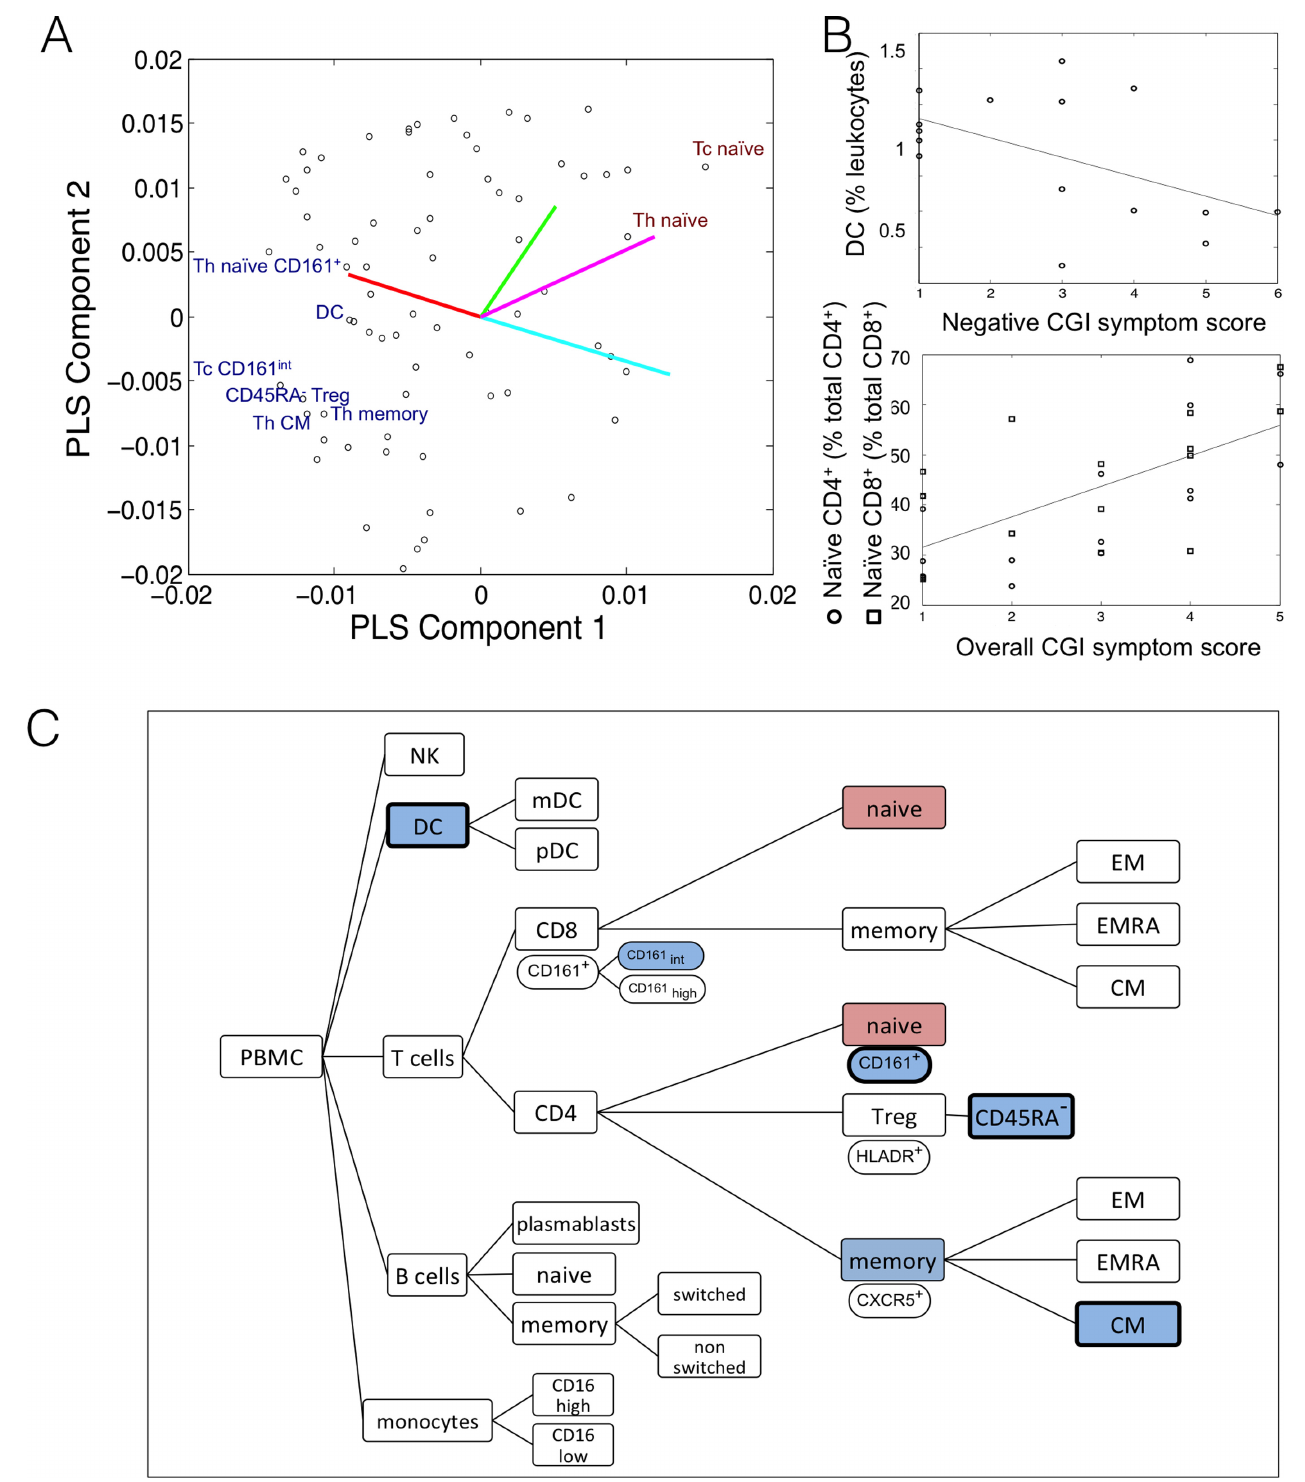
Fig 2. Immune cell populations associated with cognitive deficit and negative symptom severity in patients with clozapine-treated schizophrenia. (A) Scatter plot of the weight of individual predictor variables (immune cell populations) on the first two components of the PLS analysis. The loading vectors for each response variable are also shown: cognitive scores (BACS; red line), negative symptom scores (CGI-N; cyan line), positive symptom scores (CGI-P; green line) and overall psychotic symptom scores (CGI-O; magenta line). The first component is